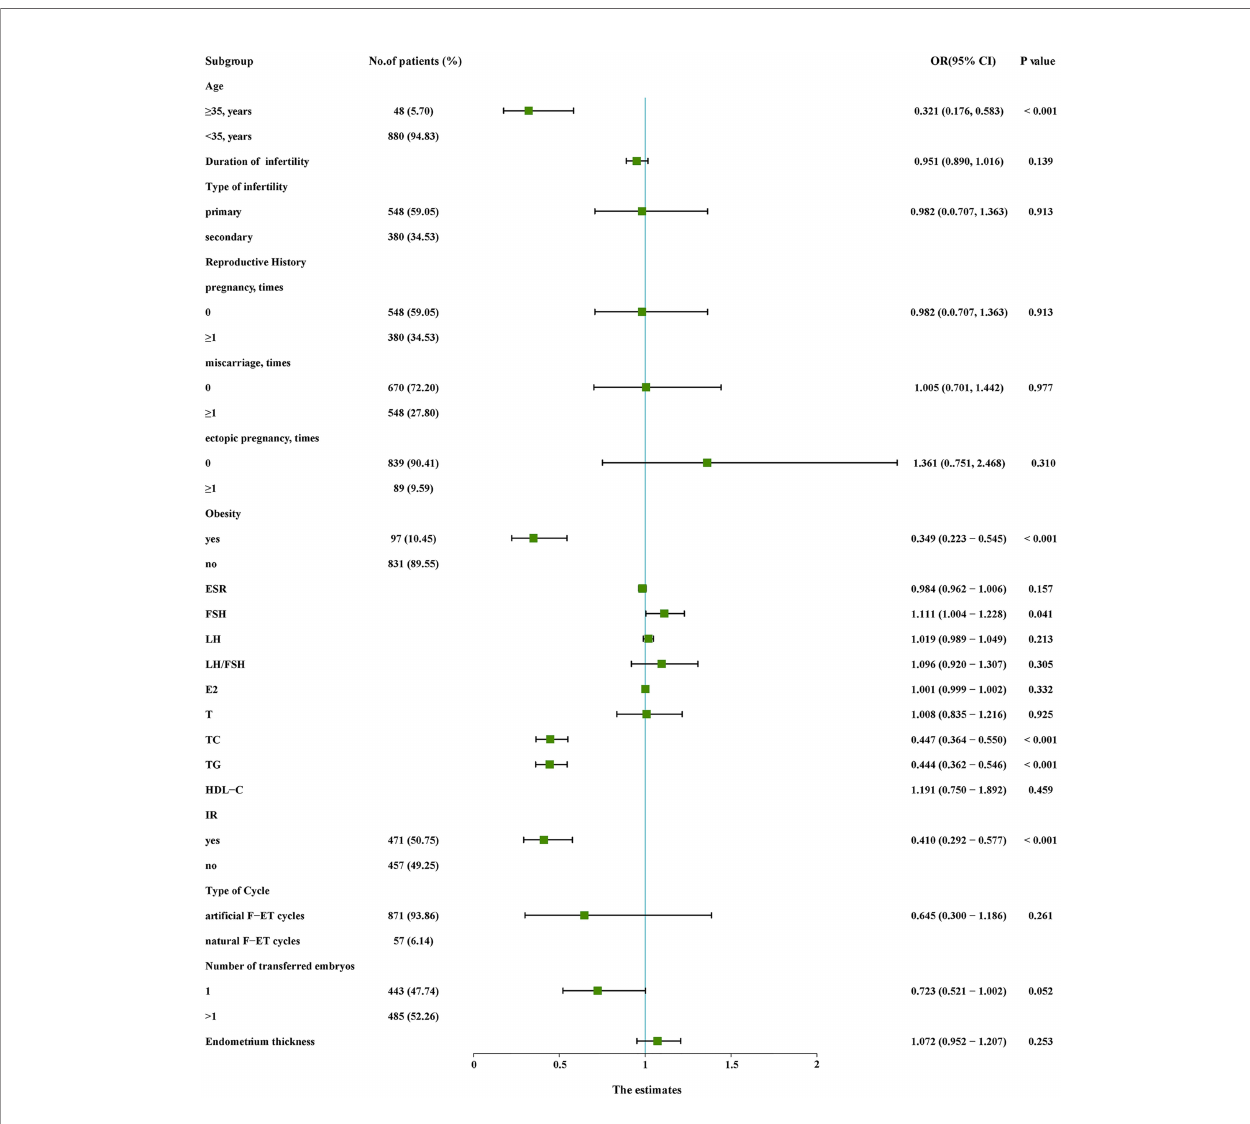
FIGURE 1 | Univariate logistic regression analyses of relevant variables in the training cohort. CI, con fi dence interval; E 2 , estradiol; ESR, erythrocyte sedimentation rate; F-ET, frozen-thawed embryo transfer; FSH, follicle-stimulating hormone; HDL-C, high-density lipoprotein cholesterol; IR, insulin resistance; LH, luteinizing hormone; OR, odds ratio; T, testosterone; TC, total cholesterol; TG,